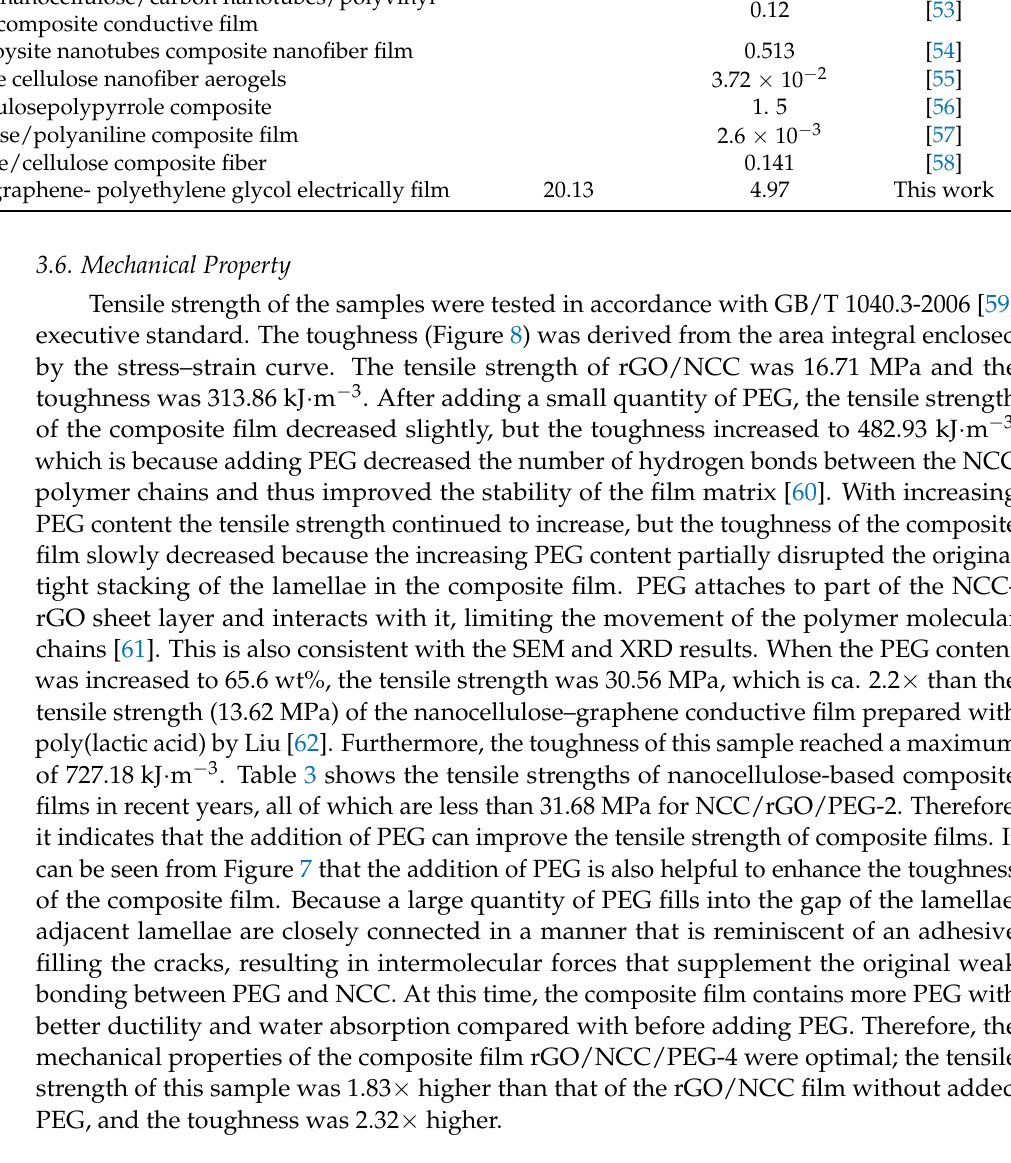
Minimum ER Maximum ( Ω · cm)